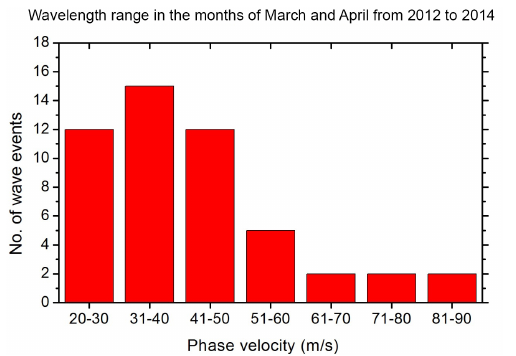
Figure 3. The distribution of the phase velocity of all the waves observed.